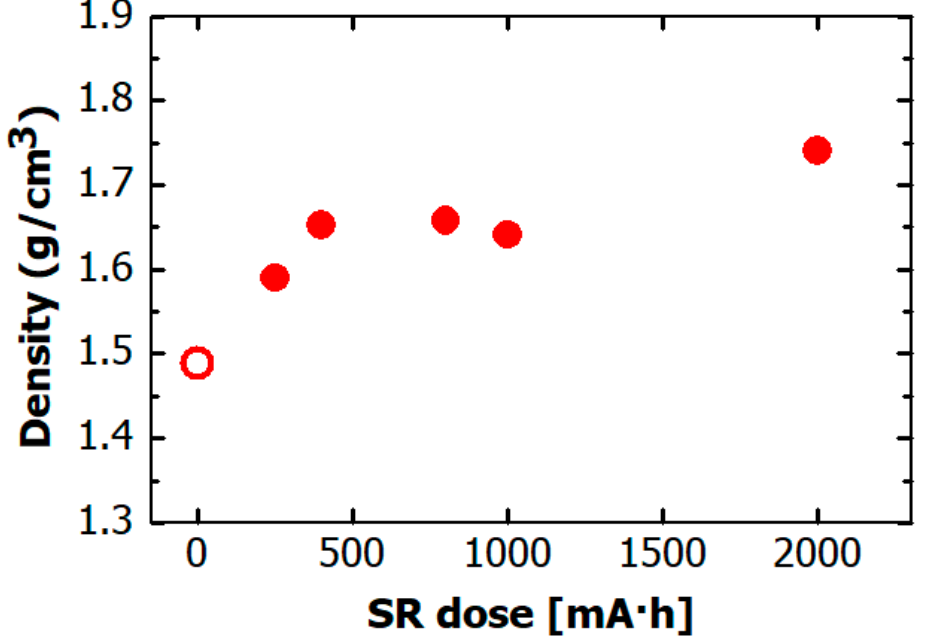
Figure 4. Dependence on SR dose of density of hydrogenated Si-DLC film. The open circle indicates density of hydrogenated Si-DLC film before SR irradiation.